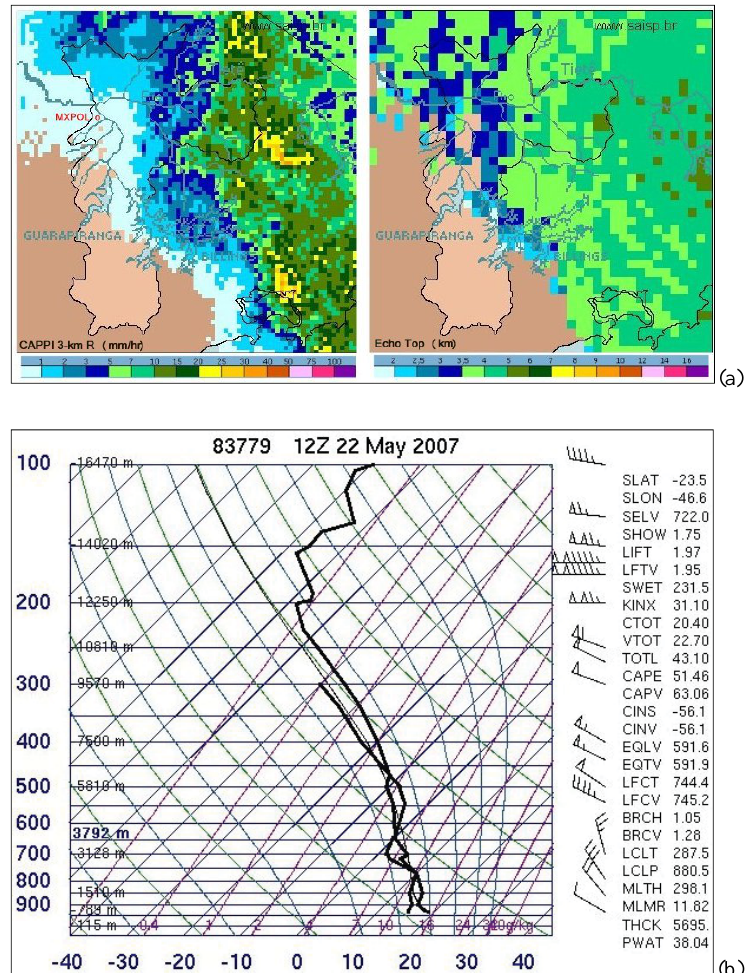
Fig. 4. CAPPI of rainfall rates at 3-km altitude (left panel) and echo tops (right panel) with 1 × 1-km horizontal resolution estimated with the S˜ao Paulo Weather Radar (SPWR) at 16:16UTC (a) and the 12:00UTC sounding at station 83779 in S˜ao Paulo City (b) on 22 May 2007. It is indicated the site (23 ◦ 33.4 0 S; 46 ◦ 44.1 0 W) of the MXPOL during the